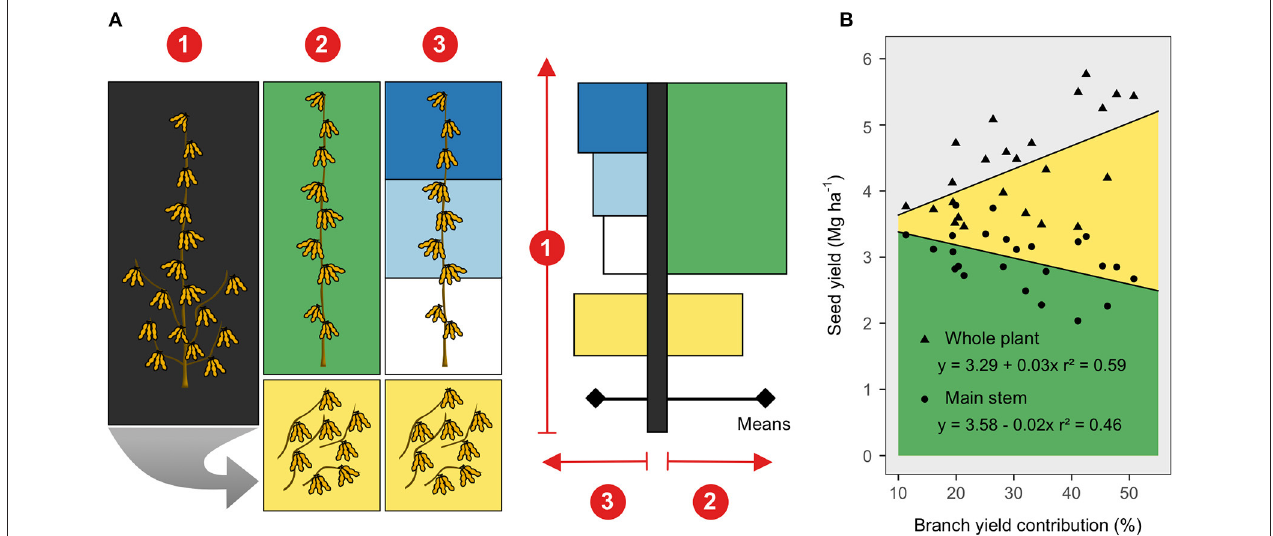
FIGURE 1 | (A) Soybean seed harvesting and bar chart representation of observed variables at three canopy levels: (1) whole plant, (2) entire main stem (green color) and stem branches (yellow color), and (3) upper (dark blue), middle (light blue), lower (white color) main stem segments and the branches. The bar chart representation was meant to resemble a soybean plant, concisely depicting the linear mixed models testing genotype and canopy portion. (B) Seed yield from the main stem (green) and branches (yellow color) relative to the branch-yield contribution (%). Regression lines were fit across genotypes and considered a random intercept for